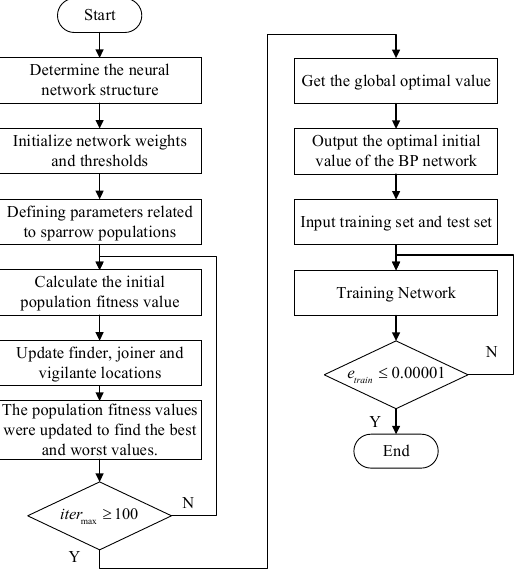
Figure 4. SSA-BP neural network algorithm flowchart. Figure 4. SSA ‐ BP neural network algorithm flowchart. Figure 4. SSA ‐ BP neural network algorithm flowchart.